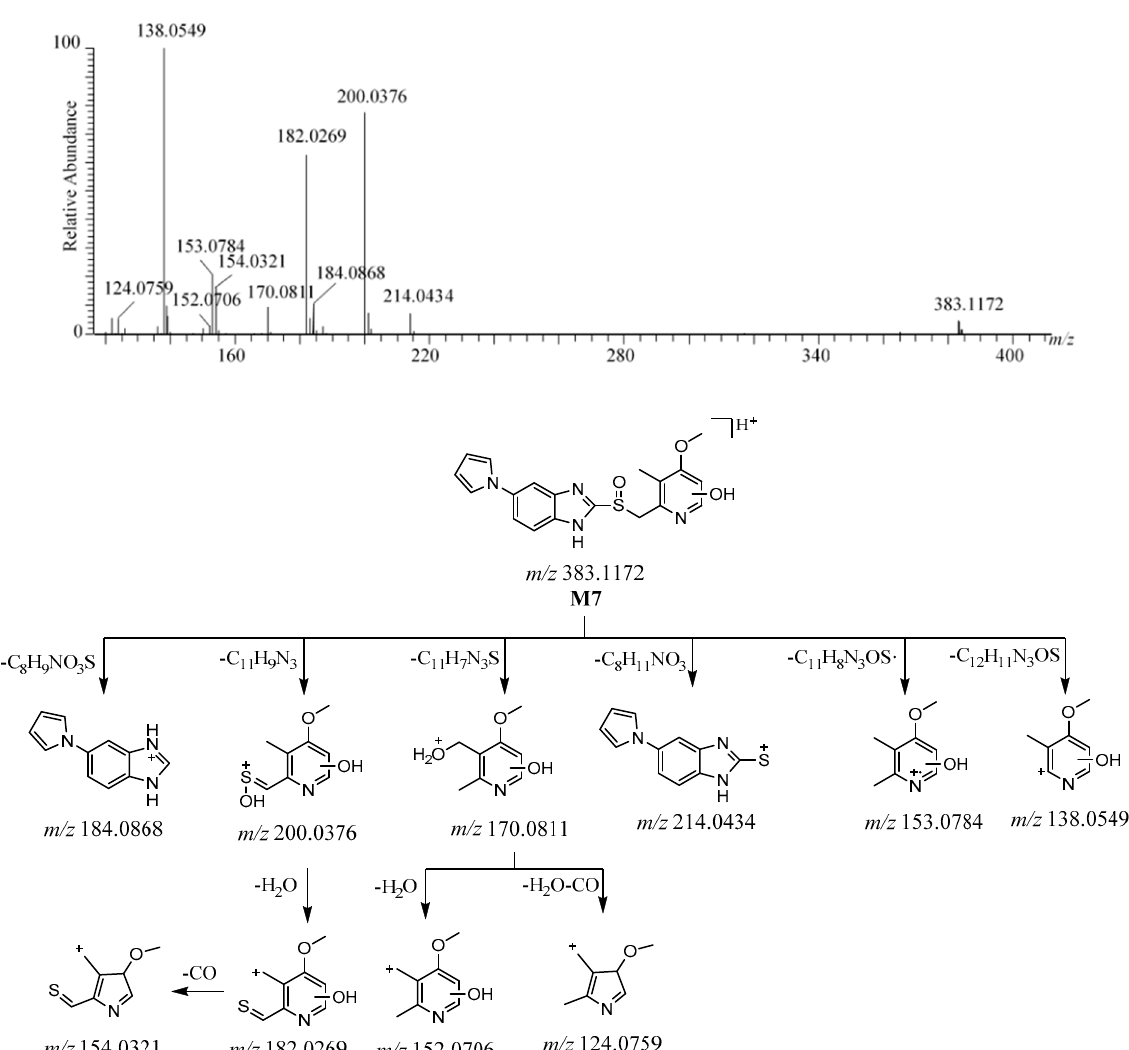
Figure 7. The HRMS/MS spectrum and the possible fragmentation pathway of M7 .